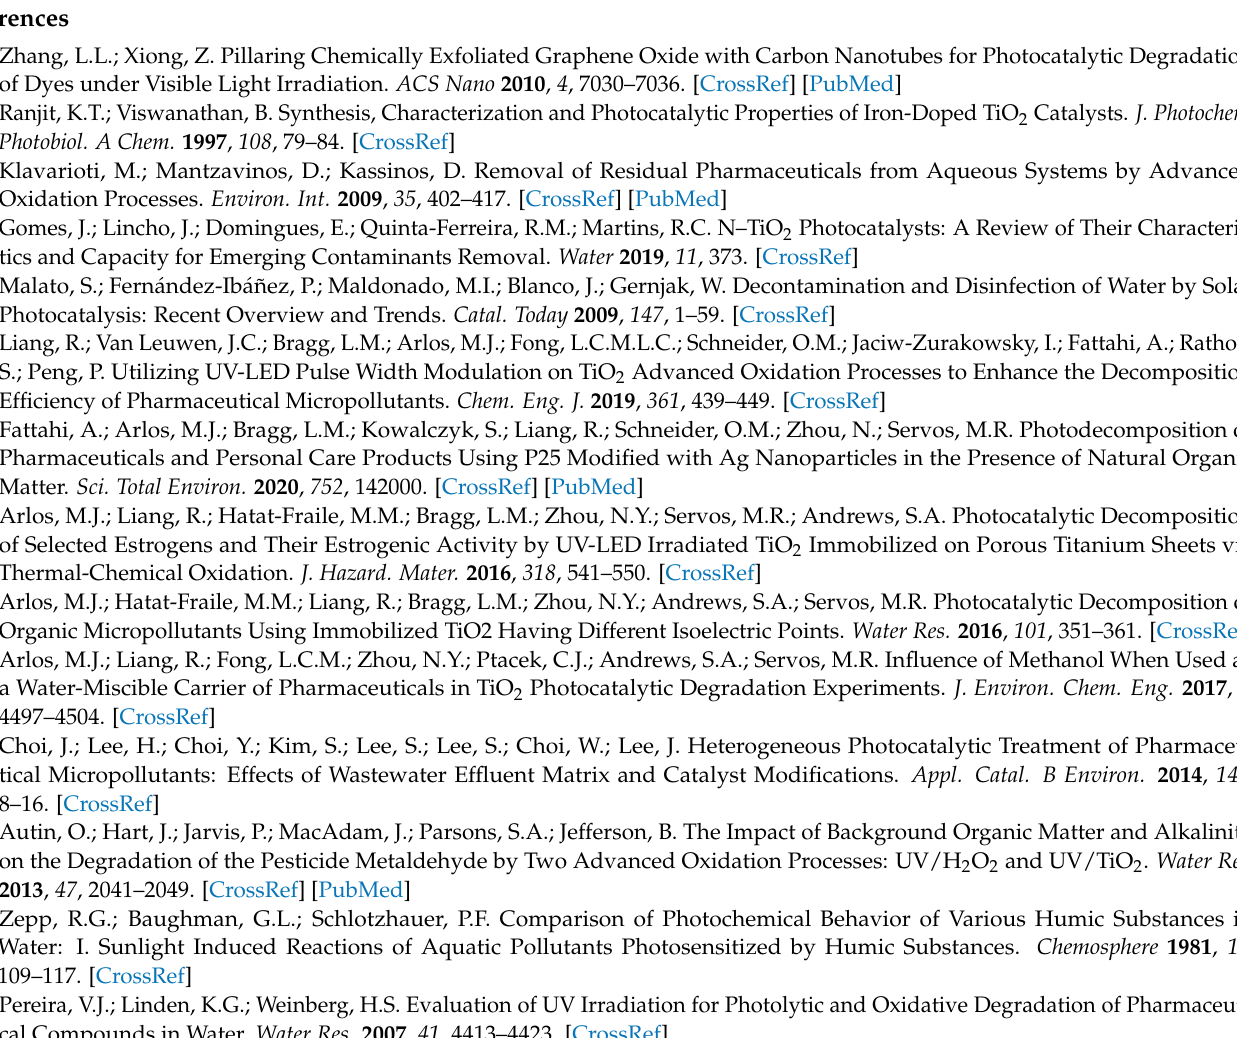
Table S3: p -values for One-Way ANOVA tests (SigmaPlot, α = 0.05) during 60 min equilibrium period, photolysis and photocatalysis.Tukey tests (multiple comparisons) were conducted when a statistical significance was detected with overall statistical significance level of 0.05; Table S4: PPCPs types and number of bonds; Table S5: Correlation coefficient in PCA matrix; Table S6: Extracted Eigenvectors in three water matrices; Table S7: Total organic carbon for wastewater effluent upon collection from the Waterloo treatment plant and after photocatalytic tests were performed on the matrix; Table S8: p -values for One-Way ANOVA tests (SigmaPlot, α = 0.05) for EEO. Tukey tests (multiple comparisons) were conducted when a statistical significance was detected with overall statistical significance level of 0.05; Table S9: Chemical and physical properties of targeted PPCPs in three water matrices and their concentrations UPW = ultrapure water; SSW = synthetic surface water; WWE = wastewater effluent; Table S10. List of PPCPs, isotopically labeled standard and suppliers. Author Contributions: Data curation, I.J.-Z.; Formal analysis, N.S.; Funding acquisition, N.Z.